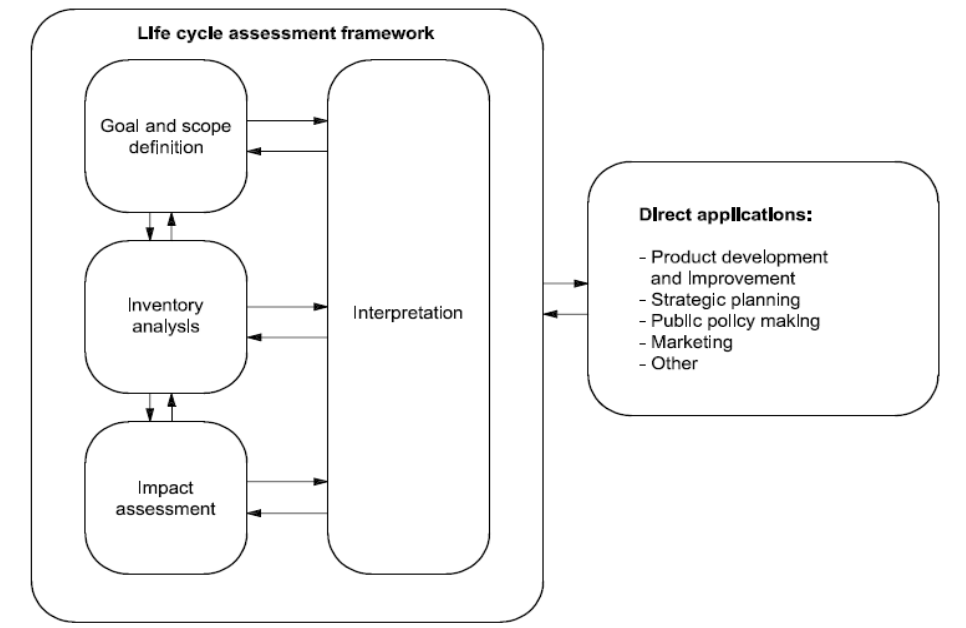
Figure 2. The four phases of a Life Cycle Assessment (LCA) study, as defined by the LCA standards (ISO 2006).